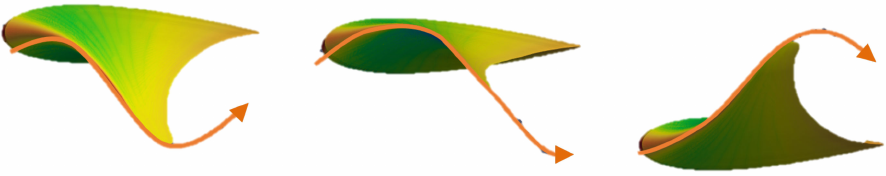
Figure 1. Highlight of the travelling wave during the motion of a cownose